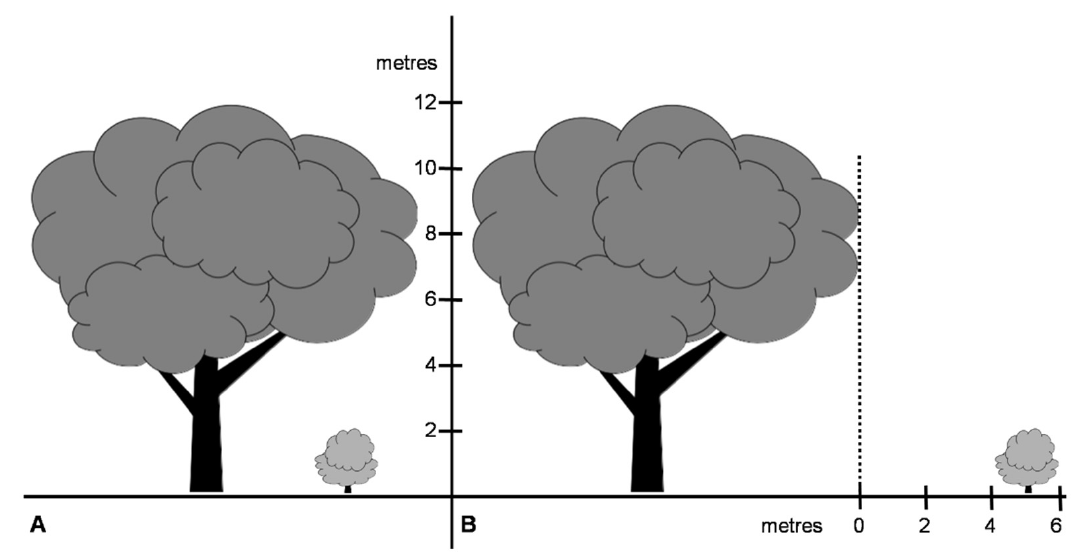
Figure 1. Position of young trees selected to sample caterpillars (mature trees— Quercus pubescens ; young trees— Q. cerris or Q. pubescens ; ( A )—in the forest interior; ( B )—in open forest glades or edges [as a solitary tree]).